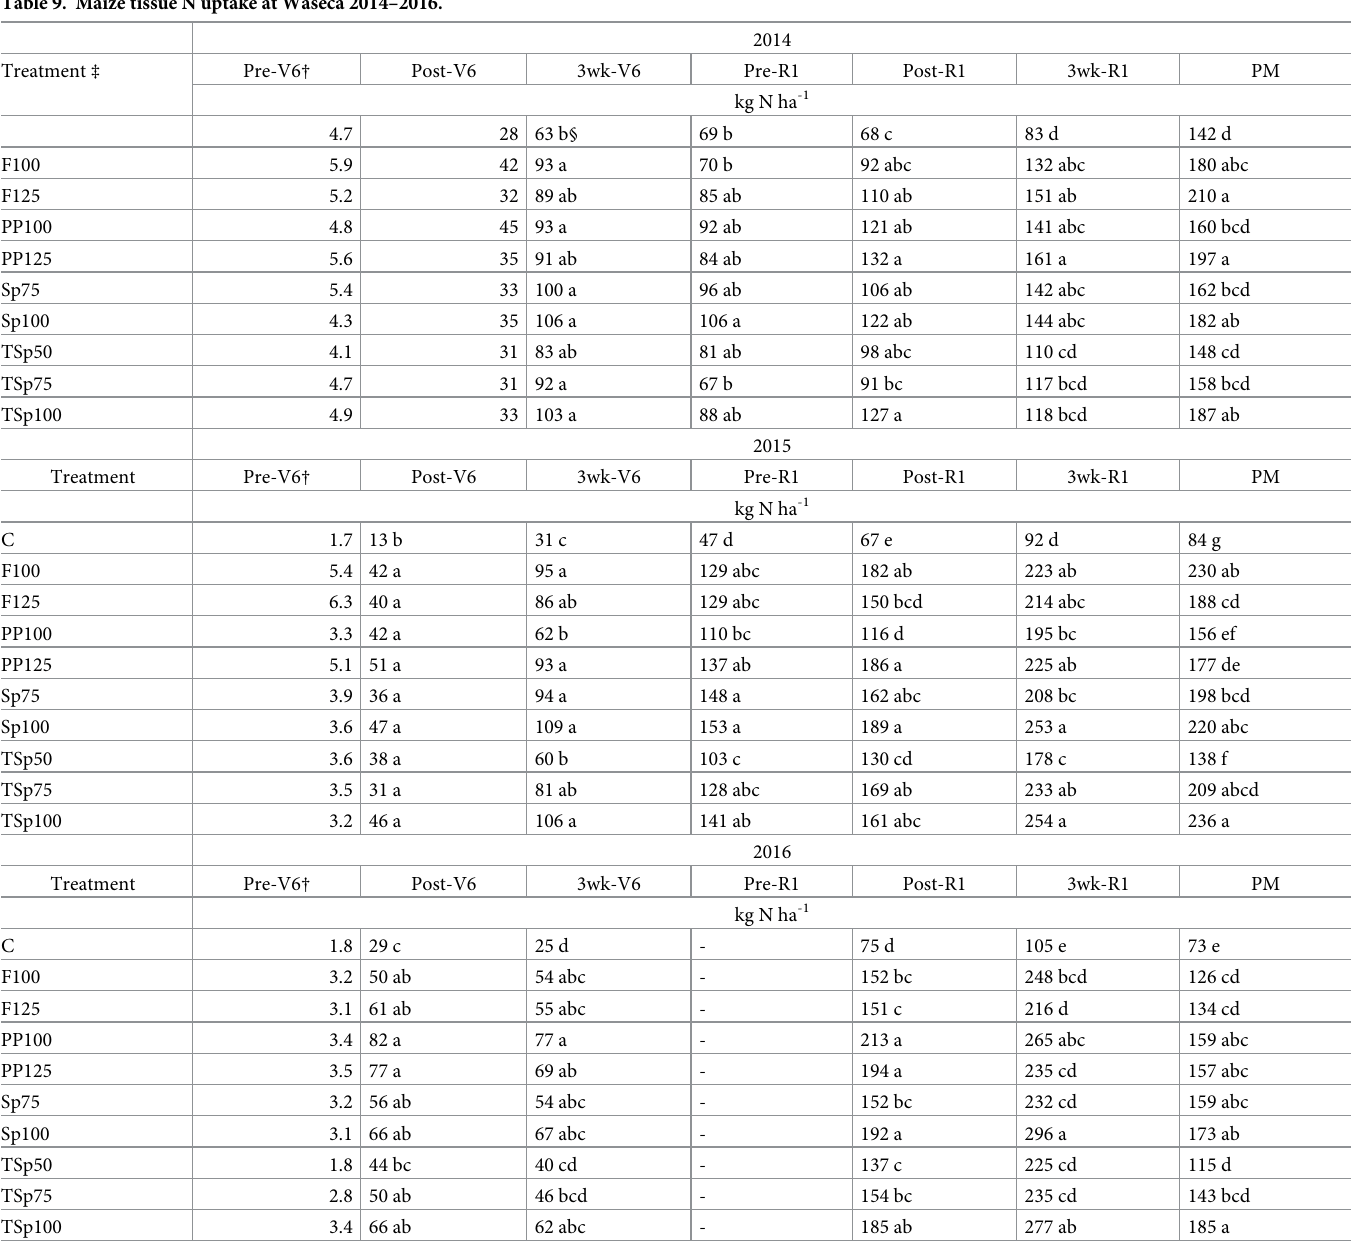
Table 9. Maize tissue N uptake at Waseca